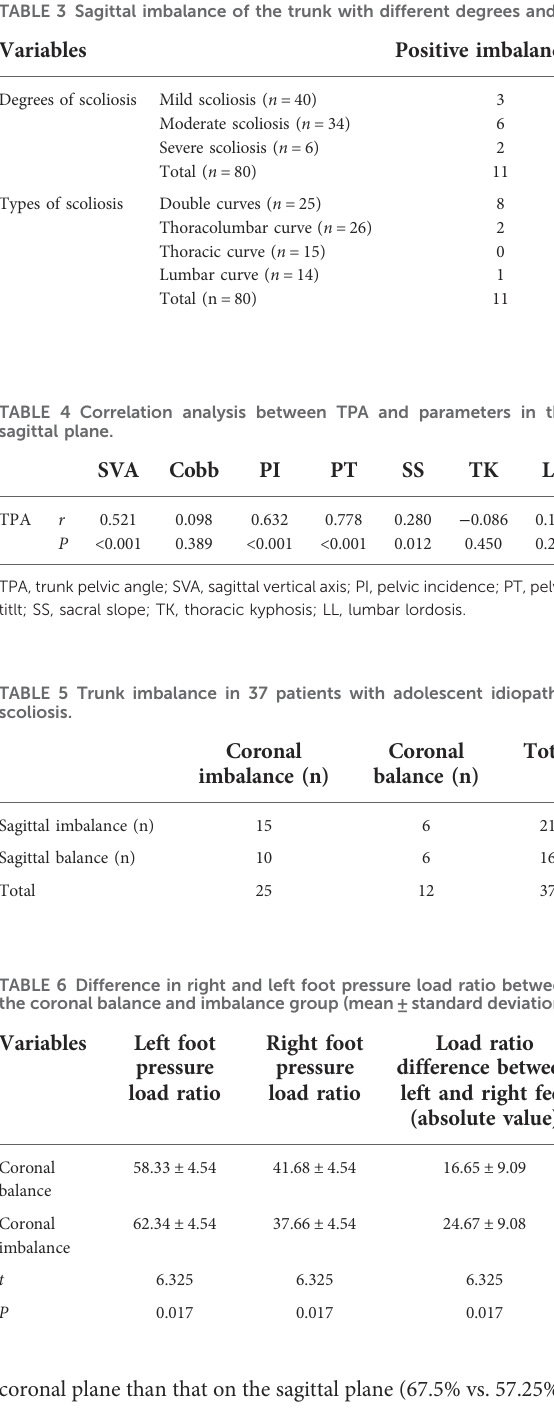
There are signi fi cantly more AIS patients with negative trunk imbalance on the sagittal plane than positive imbalance. patients show more signi fi cant local deformities, greater head offset, greater percentage difference in pressure load between the left and right foot or between anterior and posterior foot, greater COP sway area, decreased head and body standing stability, and aggravated trunk imbalance.